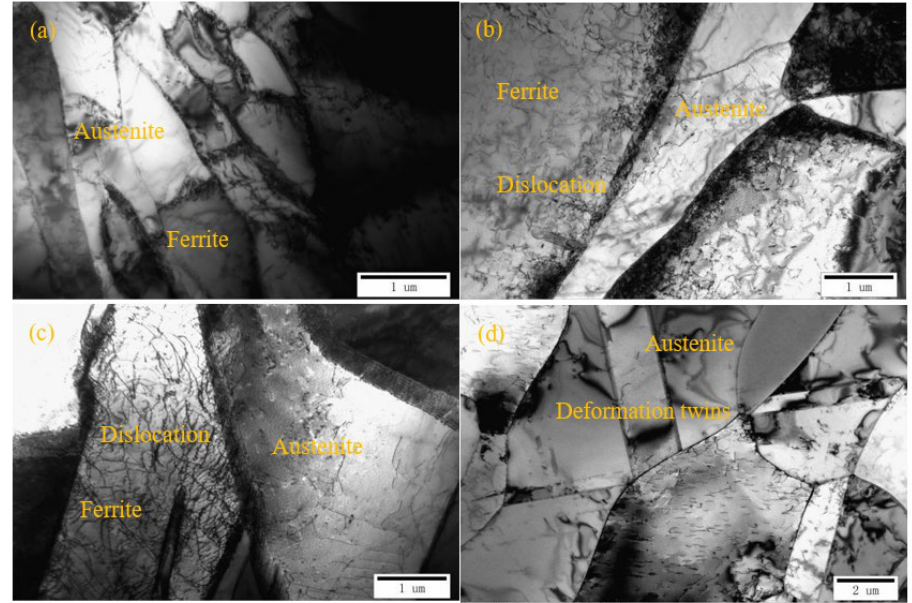
Figure 5. TEM images of DSS 2205 heat affected area with different treatment methods: ( a ) untreated; ( b ) pneumatic chipping hammer; ( c , d ) ultrasonic impact peening.